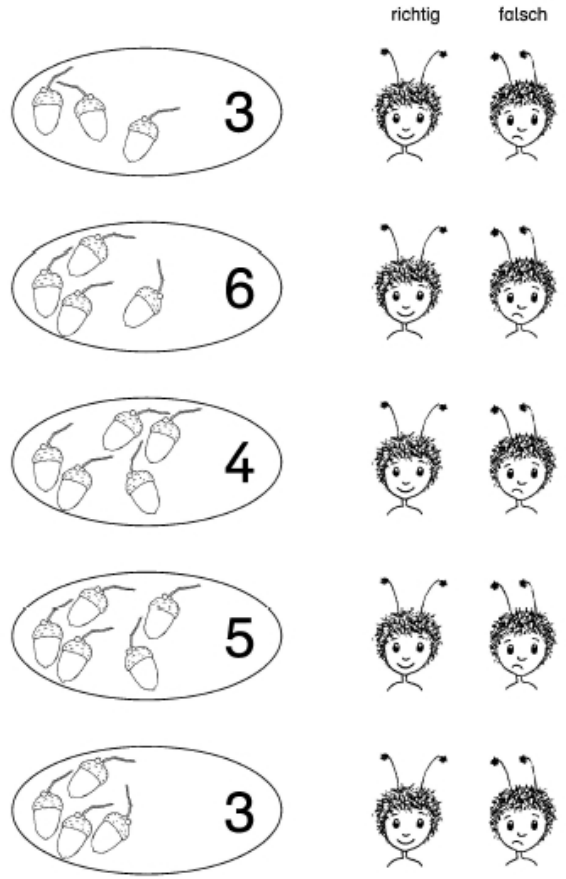
Figure 6: ‘ Has Mina counted correctly? Tick!’ (Worksheet 36 in Mina and the Mole .) Optional support